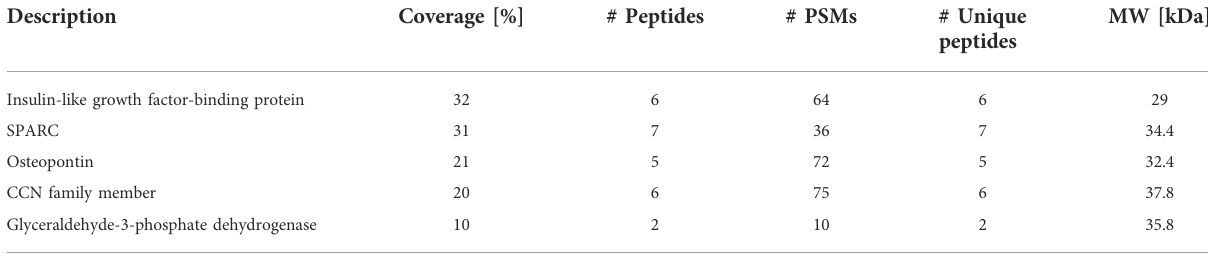
TABLE2ProteincandidatesfrombothSKOV3andMOEPTEN shRNA proteins3 – 50 kDathatful fi llparameters tobeFTEfactor.Proteincandidatesfrom both SKOV3 and MOE PTEN shRNA proteins 3 – 50 kDa that ful fi ll parameters to be FTE factor: in both Homo sapiens and Mus musculus , molecular